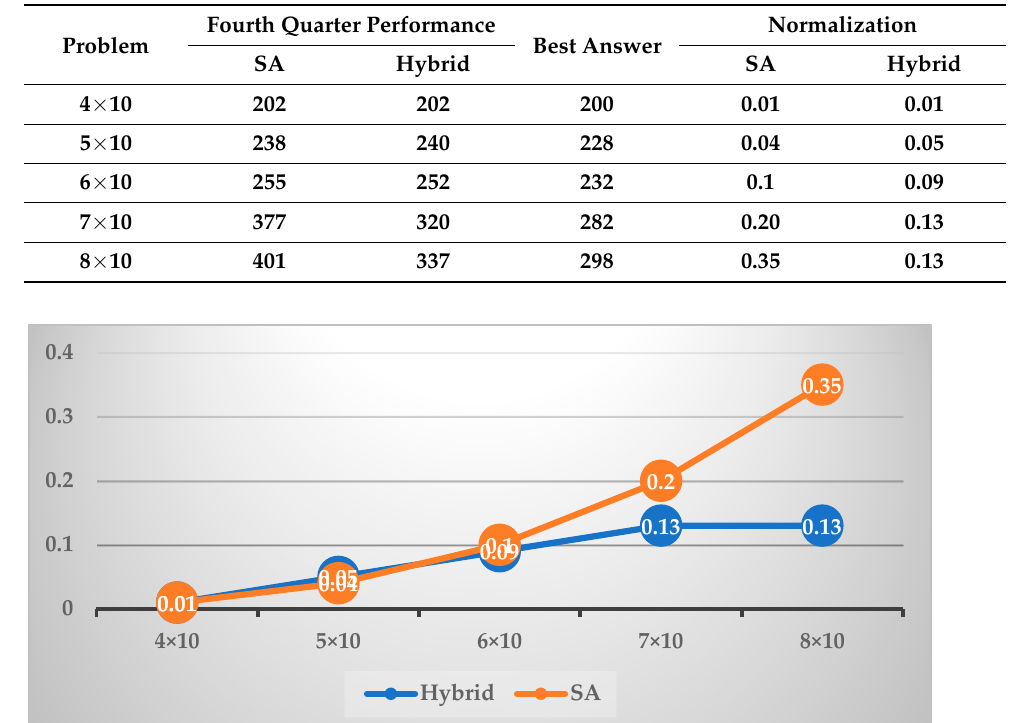
Table 9. Results of executing the SA and hybrid SA algorithms in the fourth quarter (10 ORs).